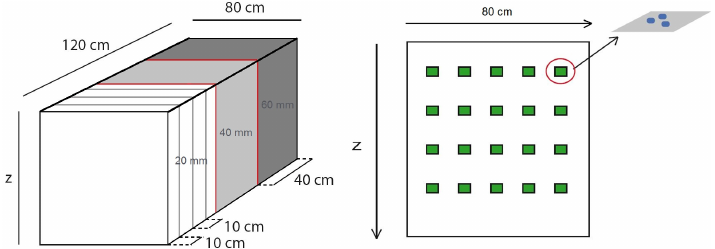
Figure 3. Scheme for profile excavation (a) and WDPT experiment (b) . The 20, 40 and 60mm in (a) denote the applied sprinkling volumes. For the WDPT experiment (b) , five sampling locations (boxes) were used traversing the profile. On every sampling location, the tests were repeated 3 times.